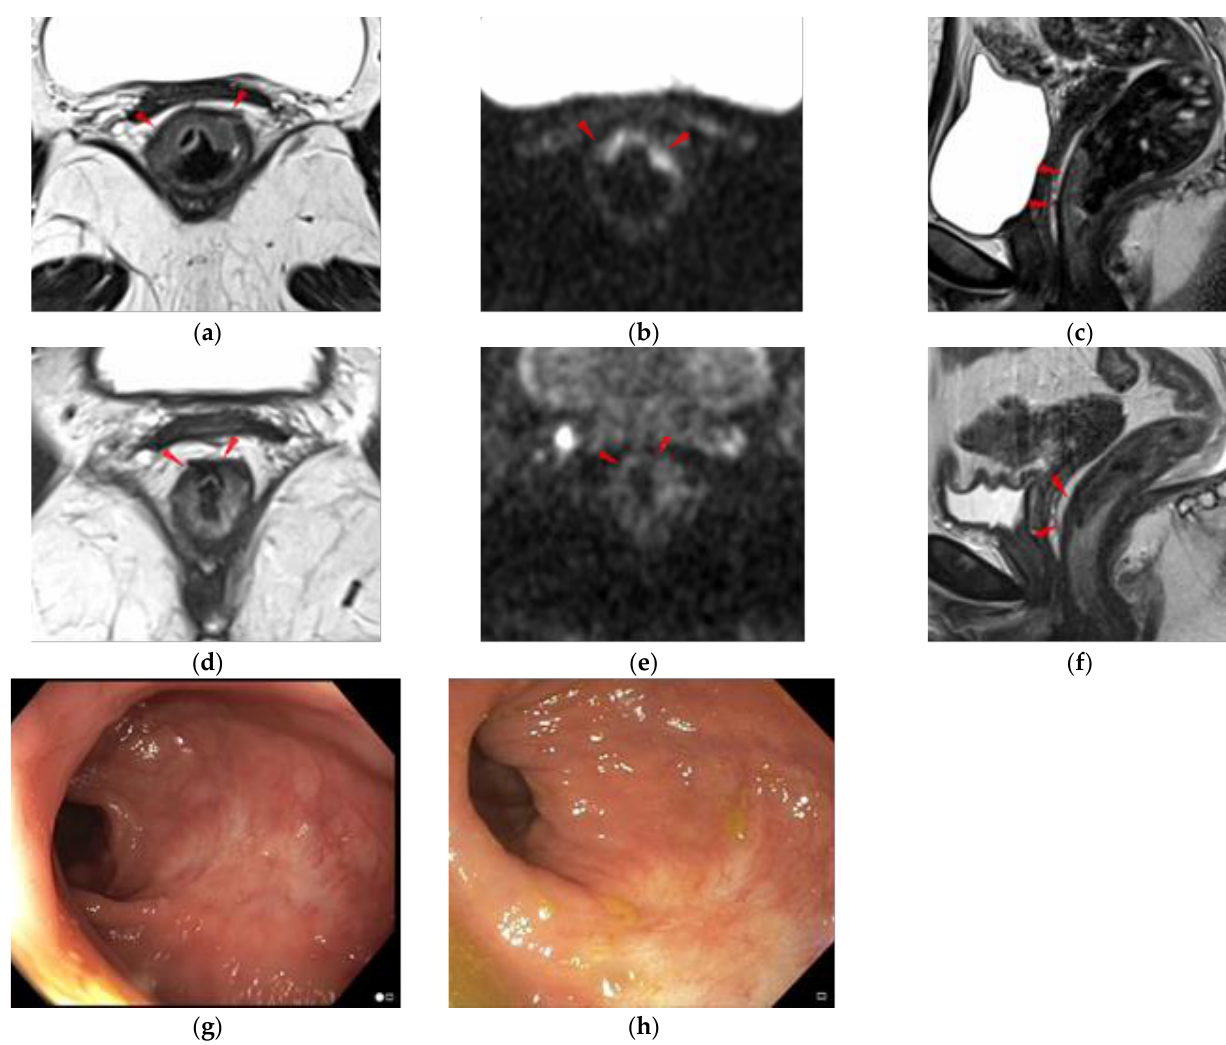
Figure 4. A 40-year-old female patient, initially staged mrLR3CRM+N+N1c+EMVI-, with a complete response at restaging MRI and endoscopy. ( a – c ) Staging MRI: axial T2WI HR ( a ), axial DWI ( b ), sagittal T2WI ( c ) showing a low rectal tumor (red arrowheads); ( d – f ) Restaging MRI after nCRT: axial ( d ) and sagittal T2WI HR ( f ) showing a pronounced reduction in size with positive split scar sign (SSS+, red arrowhead), score 0 on T2WI. No residual hyperintense signal on b ≥ 1000, with score 0 on DWI ( e ); ( g , h ) Flat white scar with telangiectasias at endoscopy, in accordance with clinical complete